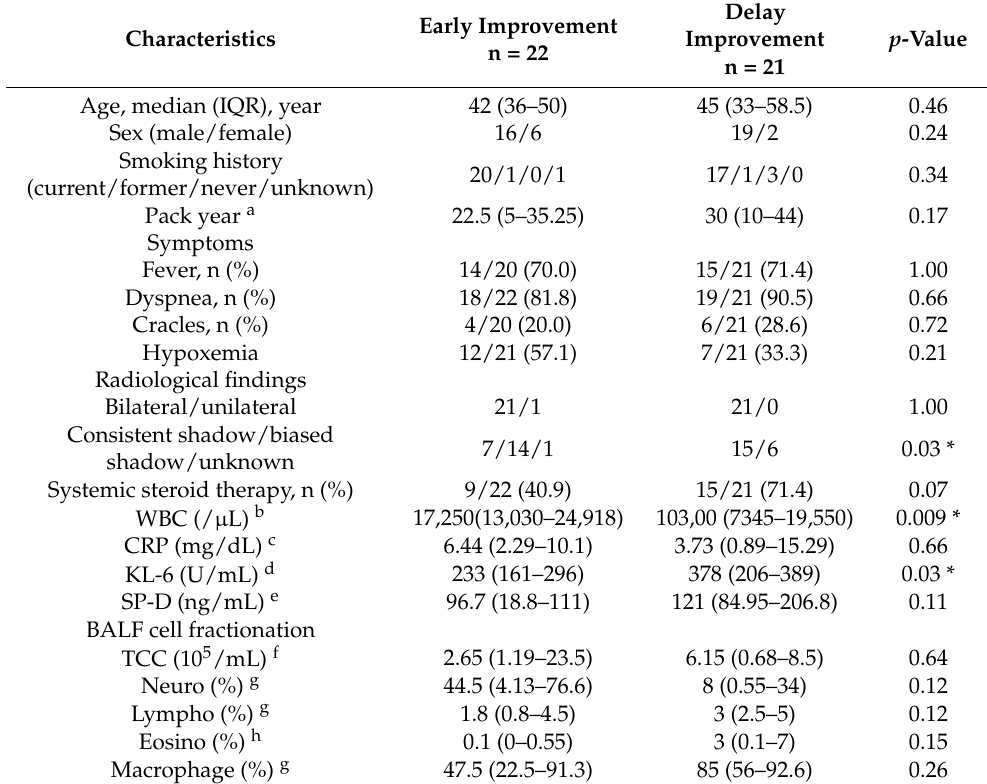
Table 1. Comparison of clinical characteristics of early and delayed improvement of WALI (n =